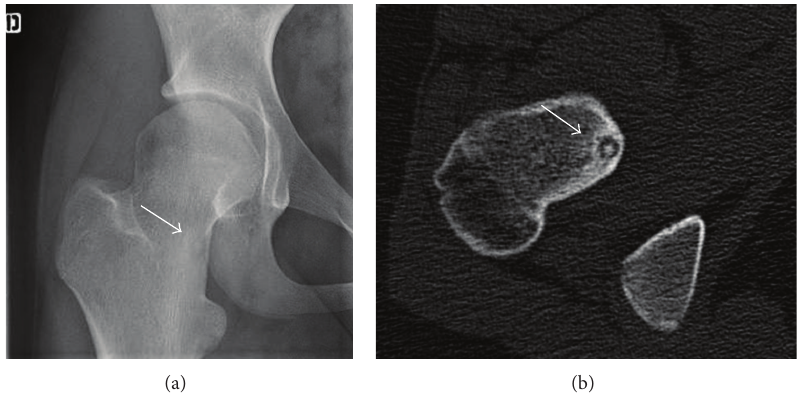
Figure 2: Same patient as in Figure 1. (a) A repeated frontal X-ray of the right hip, performed six months later, demonstrates a radiolucent nidus of femoral neck. (b) Confirmation was obtained by CT-scan.